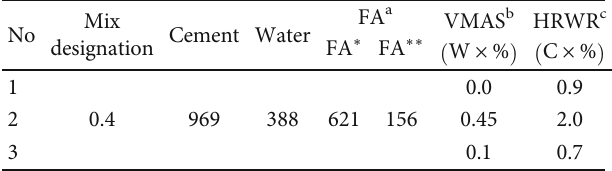
Table 1: Mix proportion of grouting mortar, kg/m 3